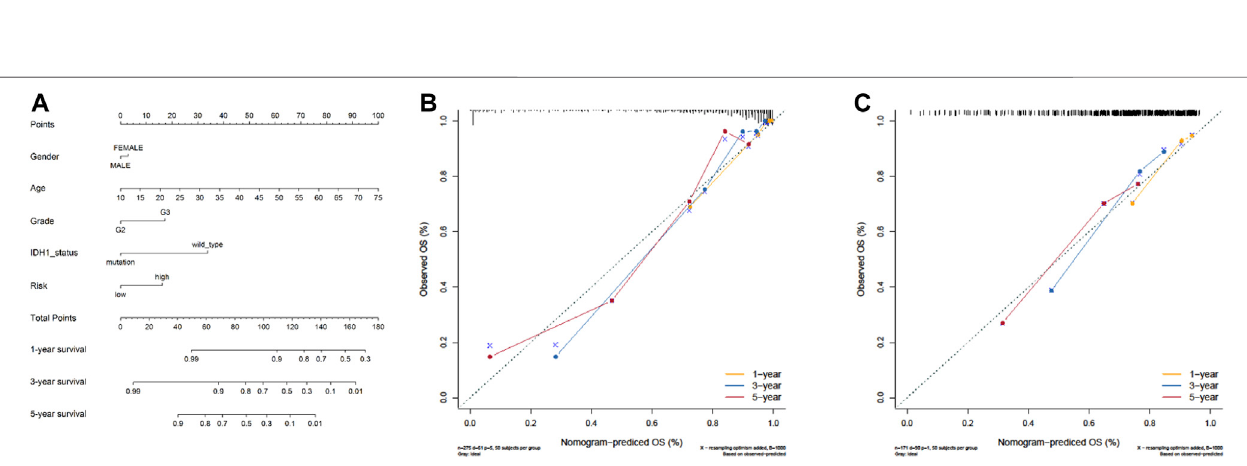
FIGURE 5 | Cox proportion hazard regression for the OS of LGG. (A, B) Univariate Cox regression analysis in TCGA derivation cohort and the CGGA validation cohort. (C, D) Multivariate Cox regression analysis in TCGA derivation cohort and the CGGA validation cohort.